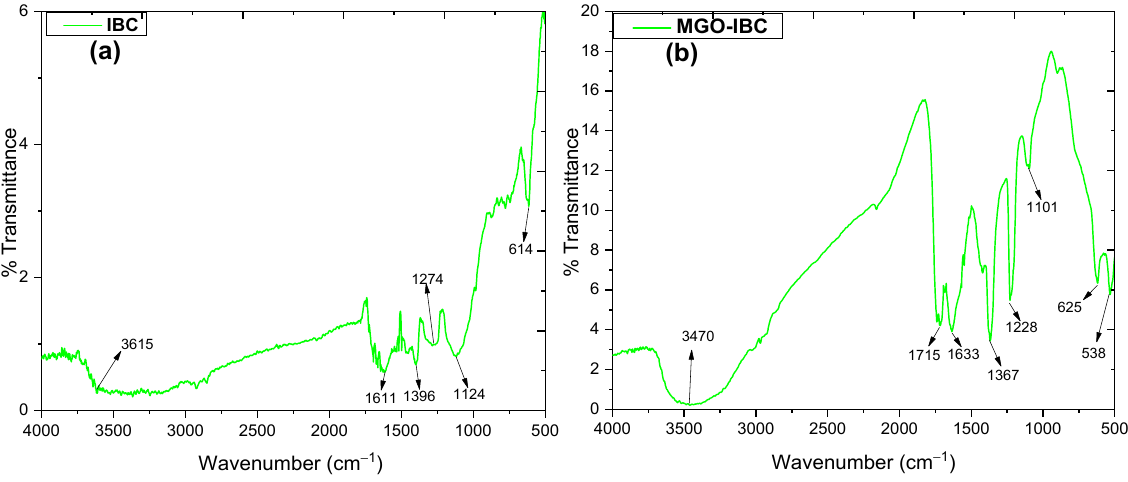
Figure 1. FTIR spectra of ( a ) IBC ( b ) MgO-IBC composite.